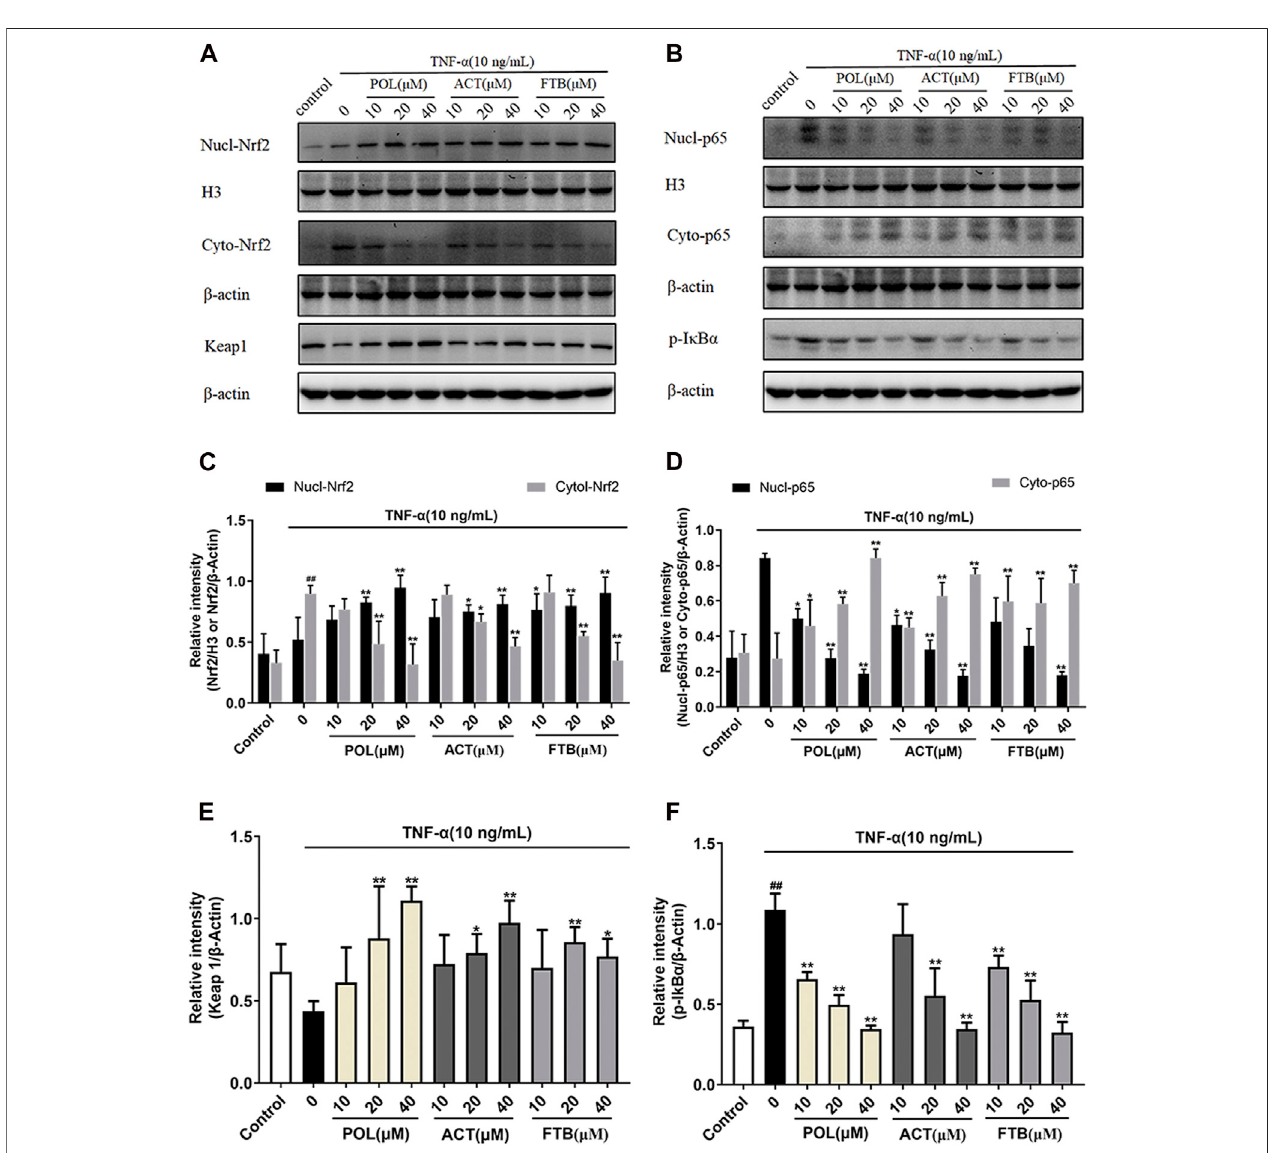
FIGURE5| EffectsofPOL,ACT,andFTBonKeap1-Nrf2andNF- κ Bp65signalingpathwaysinTNF- α -inducedcellinjuryinA549cells (A,B) Westernblotanalyses ofnucl-Nrf2,cyto-Nrf2,Keap1, nucl-p65, cyto-p65,and p -I κ B α (C – F) IntensityofKeap1, cyto-Nrf2, p -I κ B α ,andcyto-p65relativeto β -actin. Intensityofnucl-Nrf2, nucl- p65 relative to H3. Values represent the means ± SD ( n (cid:2) 3). ## p < 0.01 vs control; * p < 0.05, ** p < 0.01 vs TNF- α .